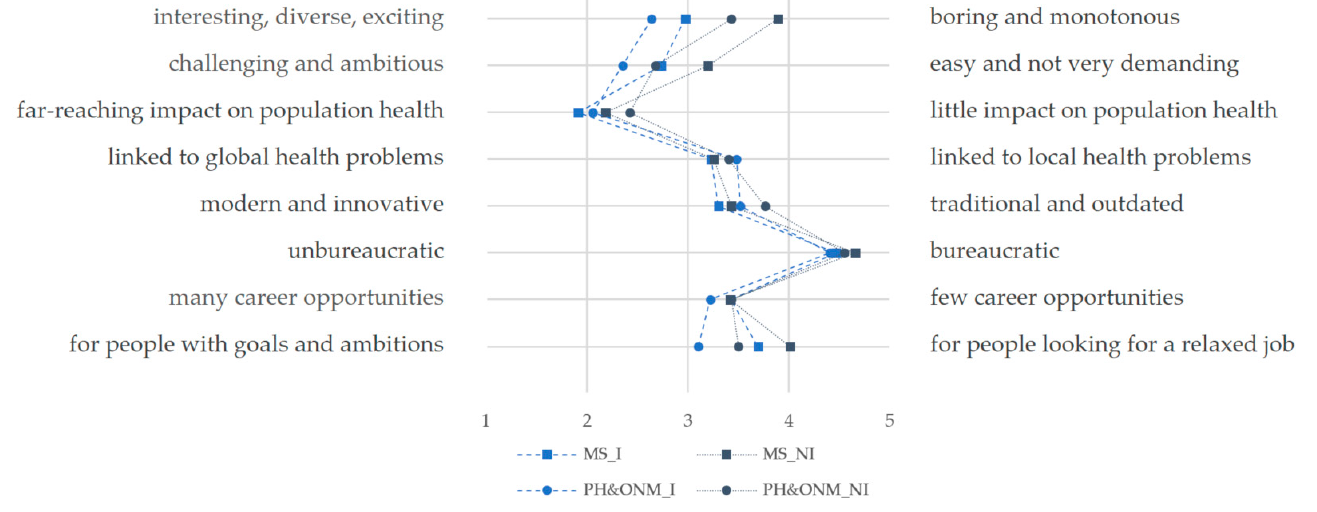
Figure 4. Polarity profile of characteristics associated with the PHS by field of study and general PHS interest of students in Germany, OeGD-Studisurvey (Abbreviations: MS_I = medical students with PHS interest, MS_NI = medical students without PHS interest, PH&ONM_I = PH&ONM students with PHS interest, PH&ONM_NI = PH&ONM students without PHS interest) .